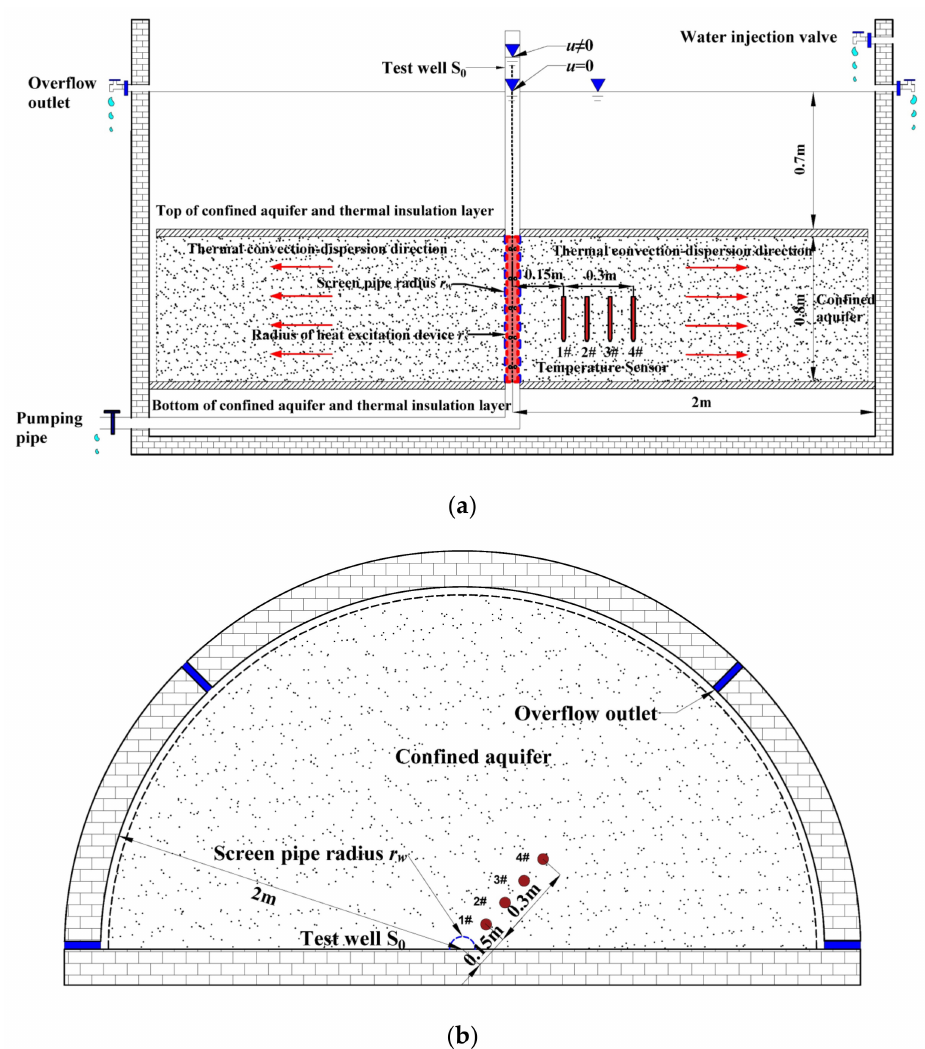
Figure 4. Indoor test platform. ( a ) Front view of the test platform (The red arrow indicates ther- mal convection-dispersion direction); ( b ) Top view of the test platform (# indicates the number of temperature